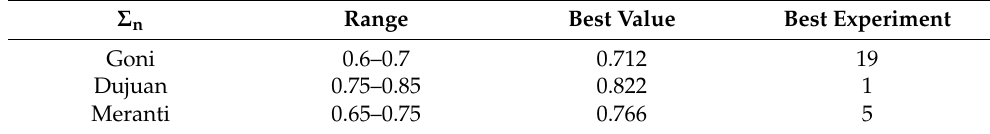
Table 14. σ n statistics of the significant wave height simulation in the three typhoon events. Σ